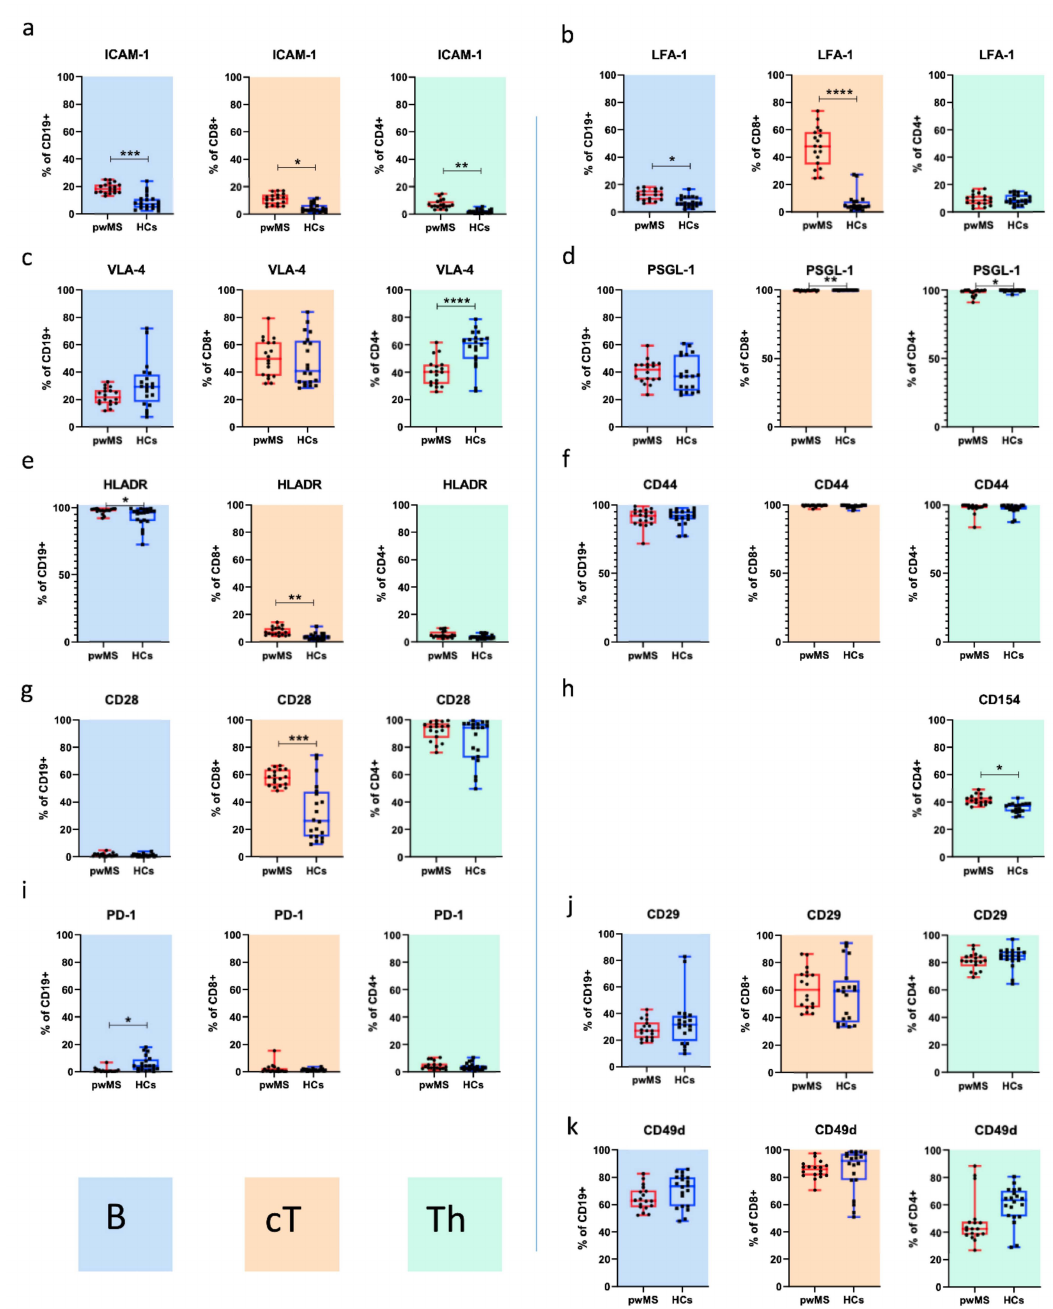
Figure 1. Baseline characteristics for adhesion and costimulatory surface molecules in healthy controls (HCs) and patients with MS (pwMS) ( a – k ) as measured by flow cytometry: frequencies of B cells/CD19+ (blue graphs), cytotoxic T cells/CD8+ (brown graphs) and T helper cells/CD4+ (green graphs). For intracellular staining with CD154, cells were stimulated for 6 h, fixed and permeabilized. We found a pro-migratory and -inflammatory profile, characterized by a higher percentage of ICAM-1 (CD19+, CD4+ and CD8+ ( a )), LFA-1 (CD19+ and CD8+ ( b )), HLADR (CD19+ and CD8+ ( e )), CD28 (CD8+ ( g )) and CD154 (CD4+ ( h )) expressing immune cells. Legends: Box-and-whisker plots show the median, interquartile range and minimum–maximum range. * p ≤ 0.05, ** p ≤ 0.01, *** p ≤ 0.001 and **** p ≤